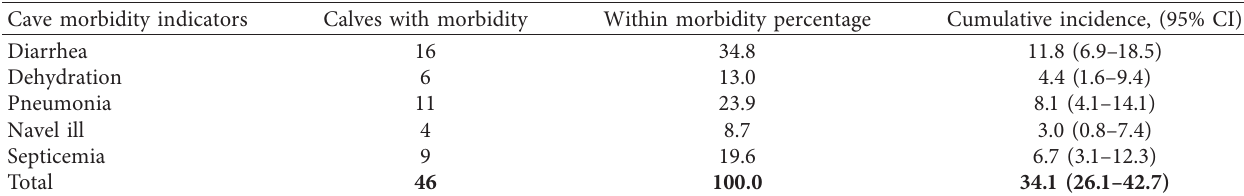
Table 3: Cumulative incidence of calves morbidity with their respective morbidity indicators ( n � 135).